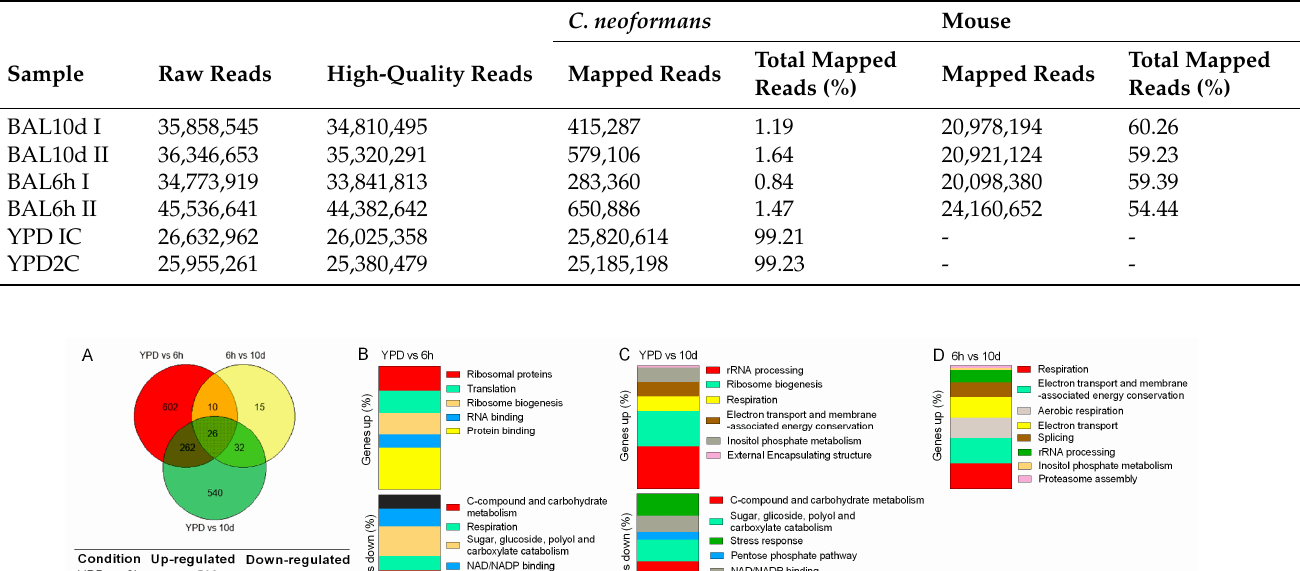
Table 3. Dual RNA-seq statistics of mapping the reads to the reference genome.